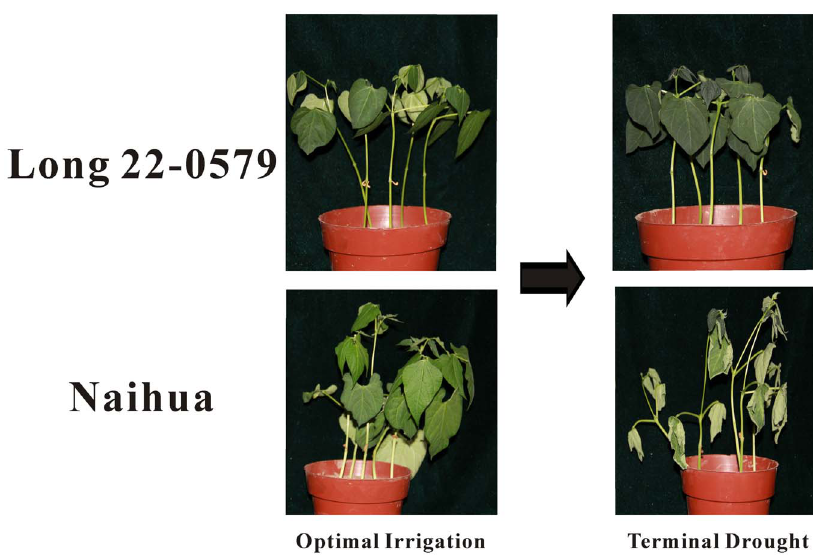
Figure 1. Phenotype of Long 22-0579 and Naihua genotypes after drought-stress treatment.